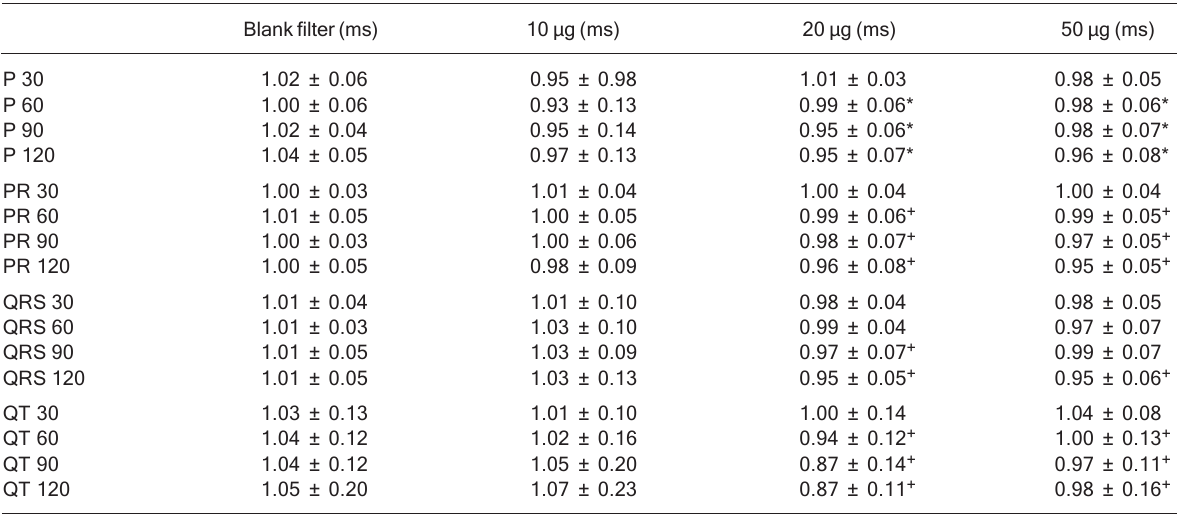
Table 5. Variations in relation to pre-instillation time (PRE) of each ECG wave segment duration (P, PR, QRS, and QT) for all experimental groups at 30, 60, 90, and 120 min after tracheal instillation of PM 2.5